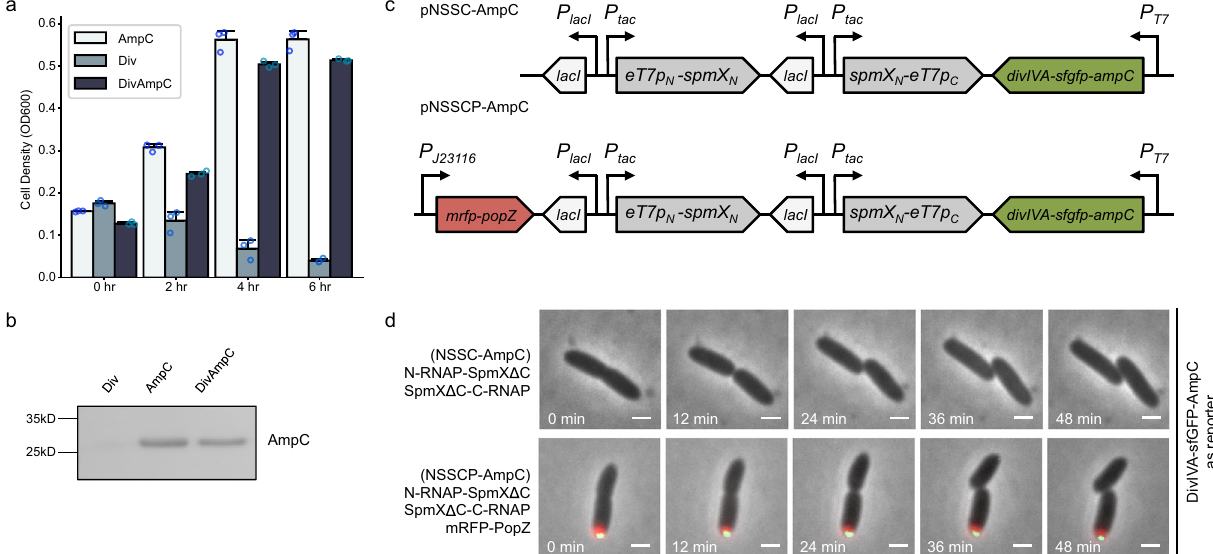
Fig. 6 Use of beta-lactamase as a cell fate determinant. a DivIVA-sfGFP-AmpC conferred resistance to ampicillin at a level that is closed to sfGFP-AmpC. DivIVA-sfGFP (Div), sfGFP-AmpC (AmpC), and DivIVA-sfGFP-AmpC (DivAmpC) were expressed from the Anderson promoter J23106; 100 μ g mL − 1 ampicillin was added to the liquid culture for the indicated times and cell growth was measured by optical density using plate reader ( “ Methods ” ). Data are presented as means ± s.d. ( n = 3 experiments). b DivIVA-sfGFP-AmpC can secrete the matured beta-lactamase to periplasm as sfGFP-AmpC. DivIVA- sfGFP (Div), sfGFP-AmpC (AmpC), and DivIVA-sfGFP-AmpC (DivAmpC) were expressed from the Anderson promoter J23106. Periplasmic extract was collected, and secreted beta-lactamase was detected by western blotting using the anti-AmpC antibody ( “ Methods ” ). c Circuit diagram for asymmetric gene expression when DivIVA-sfGFP-AmpC was used as the reporter, and SpmX Δ C was used as the adaptor for both halves of RNAP. pNSSCP and pNSSC denote plasmids containing SpmX Δ C-fused RNAP halves expressed with or without mRFP-PopZ, respectively. eT7p N -spmX N denotes the SpmX Δ C-fused PACE-evolved RNAP-N; spmX N -eT7p C denotes the SpmX Δ C-fused PACE-evolved RNAP-C. Both SpmX Δ C-fused T7 RNAP halves were expressed from the IPTG-inducible promoter, P tac . divIVA-sfgfp-ampC is the reporter gene under the expression of T7 promoter. mrfp-popZ gene was expressed from the Anderson promoter J23116. d Time-lapse imaging of SpmX Δ C-fused RNAP halves expressed with (NSSCP-AmpC, bottom) or without (NSCC-AmpC, top) mRFP-PopZ, with DivIVA-sfGFP-AmpC as a reporter. The AAV degradation tag was fused to the C-terminal of DivIVA-sfGFP-AmpC to reduce the leakage in the absence of IPTG (i.e. basal resistance to ampicillin). SpmX Δ C-fused RNAP halves were induced from the P tac promoter with 50 μ M IPTG for 3 h. Scale bars: 1 μ m. Source data are provided as a Source Data fi